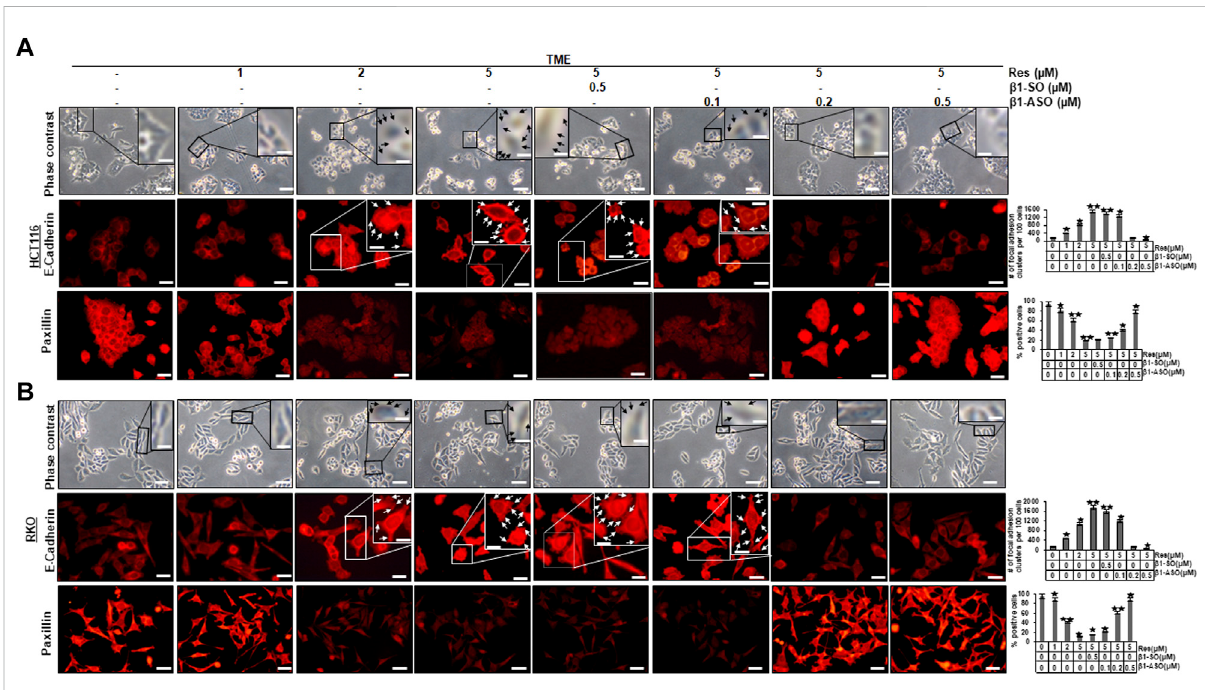
FIGURE 1 Impactofresveratrolor/andASOagainst β 1-integrinonTME-mediatedcell morphology andexpressionofE-cadherinandpaxillin inCRC cells. HCT116 (A) and RKO (B) cells were grown on coverslips in TME, left untreated or treated with increasing doses of resveratrol (1, 2, 5 µM) or were transfected with β 1-SO or β 1-ASO as outlined in Material and Methods. After rinsing with phosphate-buffered water, the cell morphology of CRC cellswasexaminedbyphasecontrast (A,B) ,(toproweach ) .Immunolabeling(red)withanti-E-cadherin (A,B) ,(middleroweach ) orpaxillin (A,B) , (bottom row each) was observed by immuno fl uorescence microscopy. Special attention is paid to the discovered resveratrol-induced plaque-like deposits, highlighted with black (A,B) , (top row each) and white (A,B) , (middle row each) arrows. Statistical analysis: Plaque-like deposits were quanti fi ed by couting in 20 different microscopiy fi elds. Related to TME control, * p < 0.05 and ** p < 0.01. Microscope: Leica DM 2000. Magni fi cation ×600; scale bar = 30 µm. Inset magni fi cation: ×1200; scale bar = 15